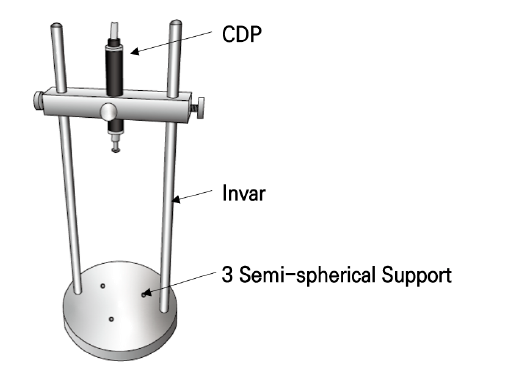
Figure 2. Experimental apparatus for measuring COTE and system setup [45].